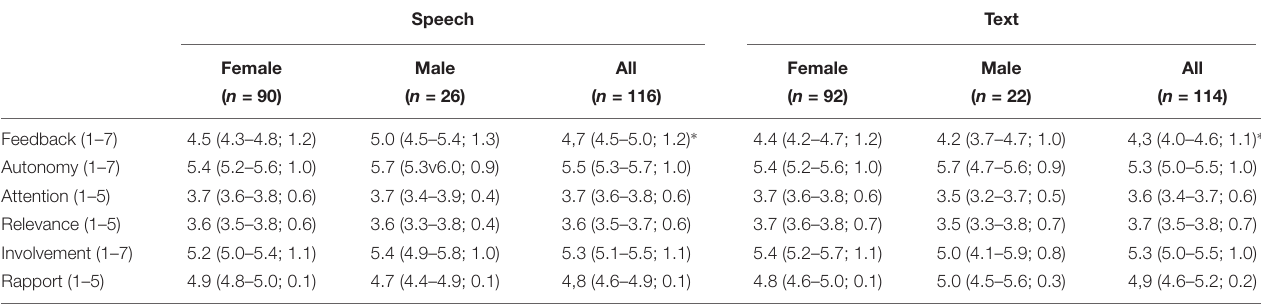
TABLE 2 | Mean scores and standard deviation on the speech-text distinction.